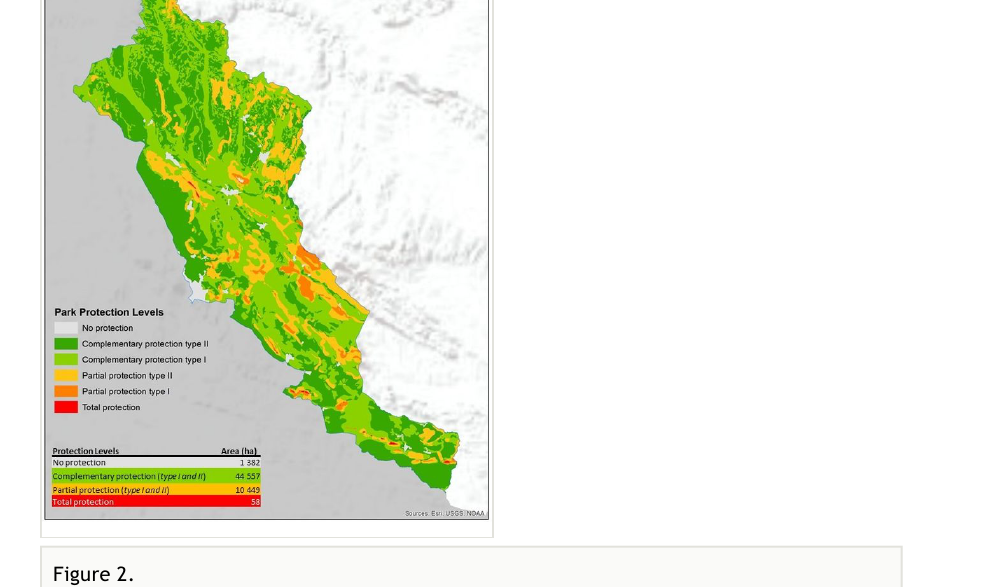
Figure 2. PNSSM protection